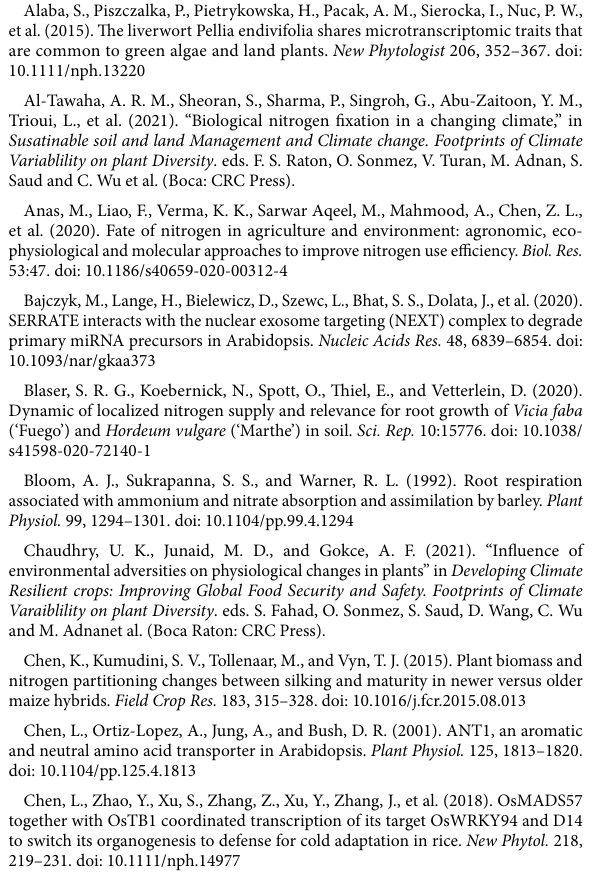
SUPPLEMENTARY FIGURE S7 Analysis of length of seminal and lateral roots in WT, mads27 kd and mads27 c-Myc OE plants in control and N excess stress conditions. In the case of all mads27 c-Myc OE mutant lines, seminal roots are longer while lateral roots are shorter in comparison to WT plants in control conditions. Upon N excess stress seminal roots in WT and mads27 c-Myc OE mutant plants are shorter and similar in length as in WT plants. Different capital letters indicate significant difference between root length means among WT, mads27 c-Myc OE , and mads27 kd within a given nitrogen condition and the same letters indicate lack of statistical significance according to Dunn test. Error bars represent the standard error. value of p <0.05. SUPPLEMENTARY FIGURE S8 RNA-seq data from roots of WT barley plants grown in control conditions and N excess stress. Volcano plot representing comparison between RNA-seq data from roots of WT plants grown in control and N excess stress. Red dots depict genes changed with statistical significance based on p -value of Bonferroni correction. X-axis shows normalized counts and y-axis represents gene expression fold change. SUPPLEMENTARY FIGURE S9 ChIP-qPCR results of candidate genes for regulation by HvMADS27. (A–E) Depict the results of ChIP-qPCR for HvANT1 , PPC1 , UPS1 , LACCASE , and NRT1.1 promoter genes, respectively. Black boxes represent promoter sequences, grey boxes depict gene bodies, and blue lines flank the position of CArG motifs. The exact positions of motifs were provided by the numbers of nucleotides upstream of the